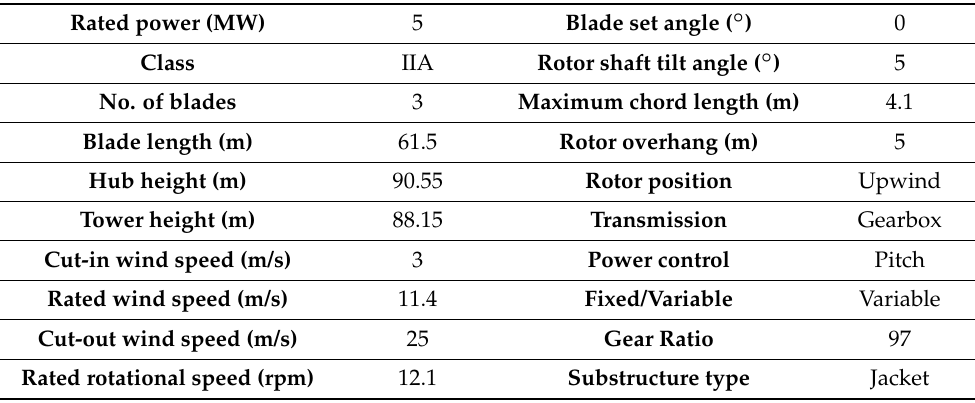
Figure 6. Boundary and load conditions in finite element analysis. Table 3. Specifications for a 5 MW wind turbine [14].